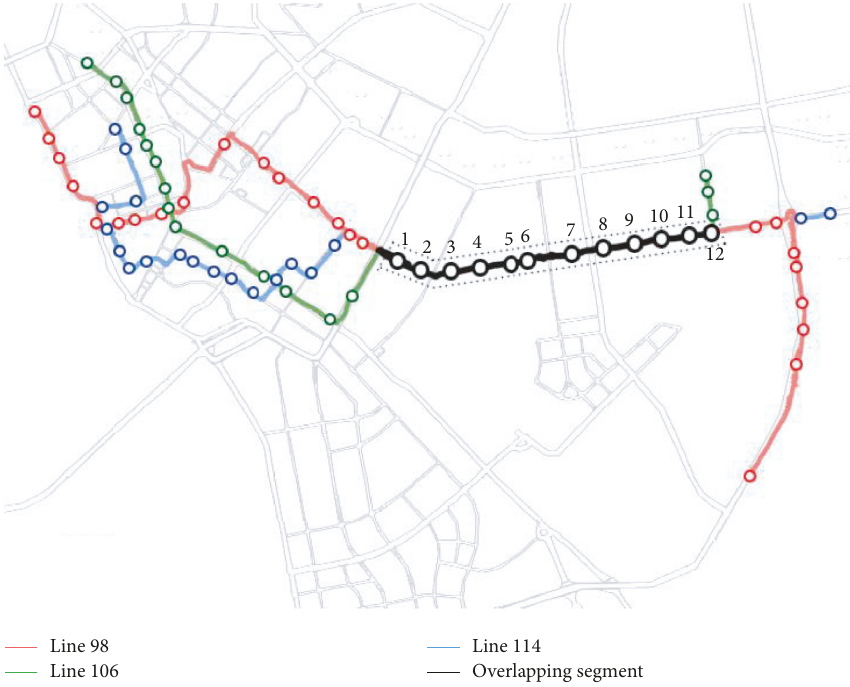
Figure 4: Overlapping segments in a bus line network in Harbin,